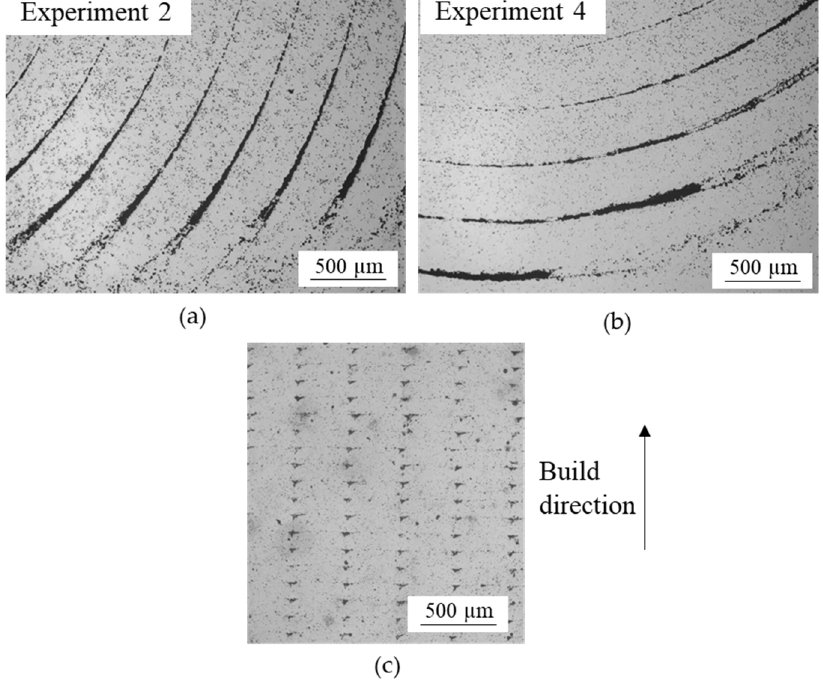
Figure 9. Opto-digital cross-sectional micrographs of ( a ) experiment 2, ( b ) experiment 4 and ( c ) longi- tudinal section of vertical parts.